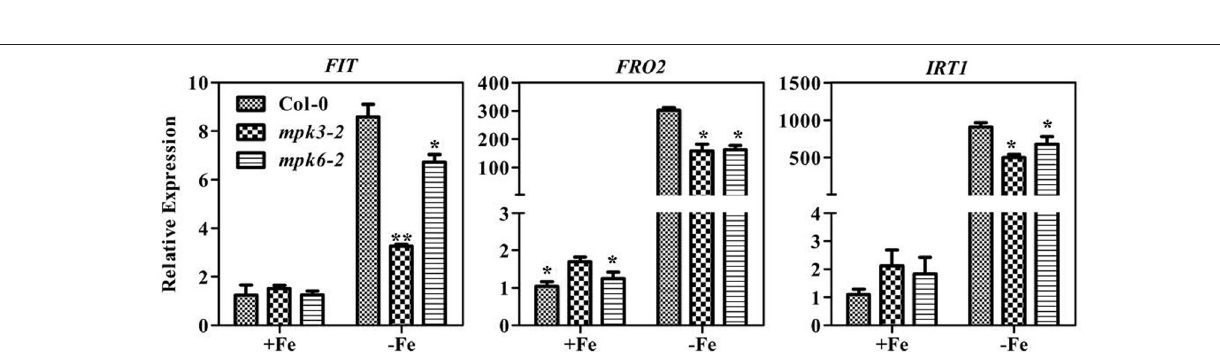
ACS11 in this study was not detected by García et al. (2010).